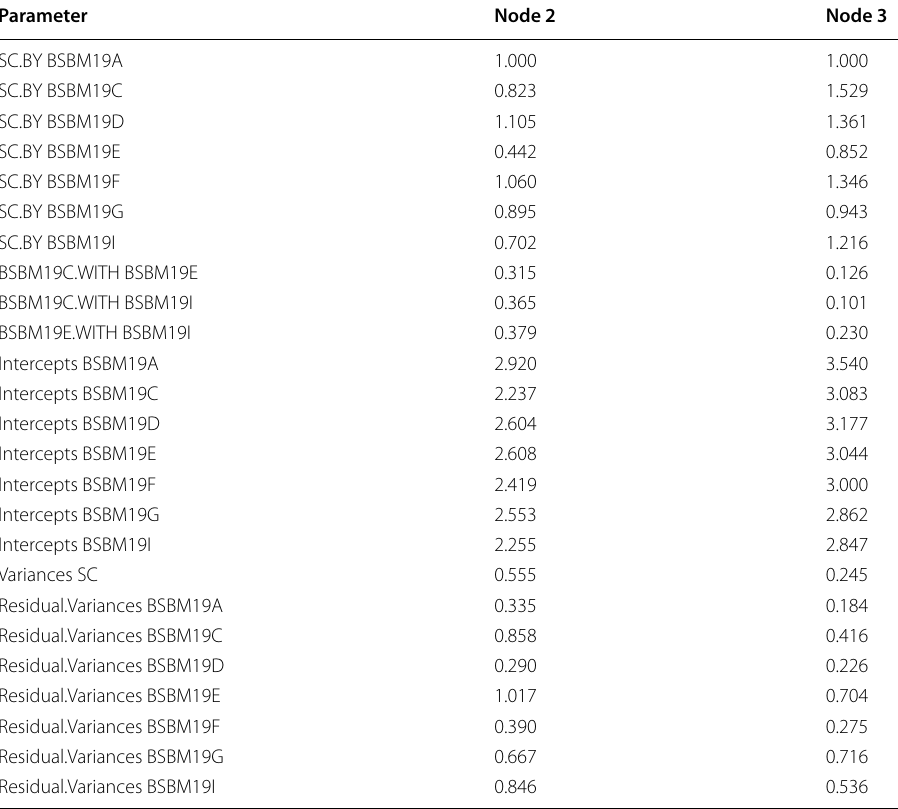
Table 3 Parameter estimates for terminal nodes from Mplus tree with complexity parameter of